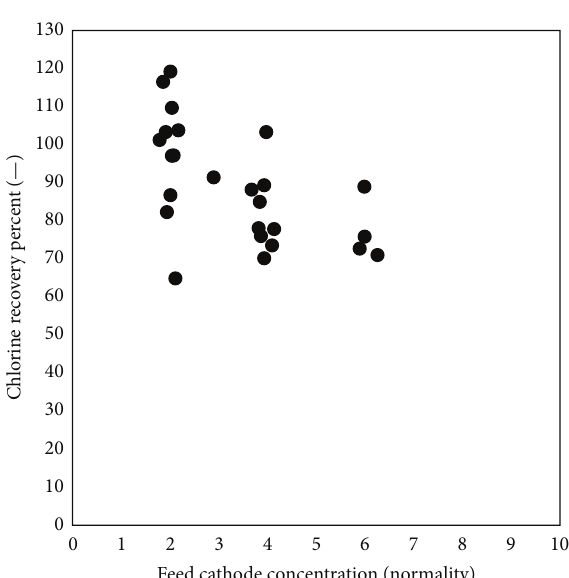
Figure 5: Hydrogen recovery percent (—) versus feed catholyte concentration